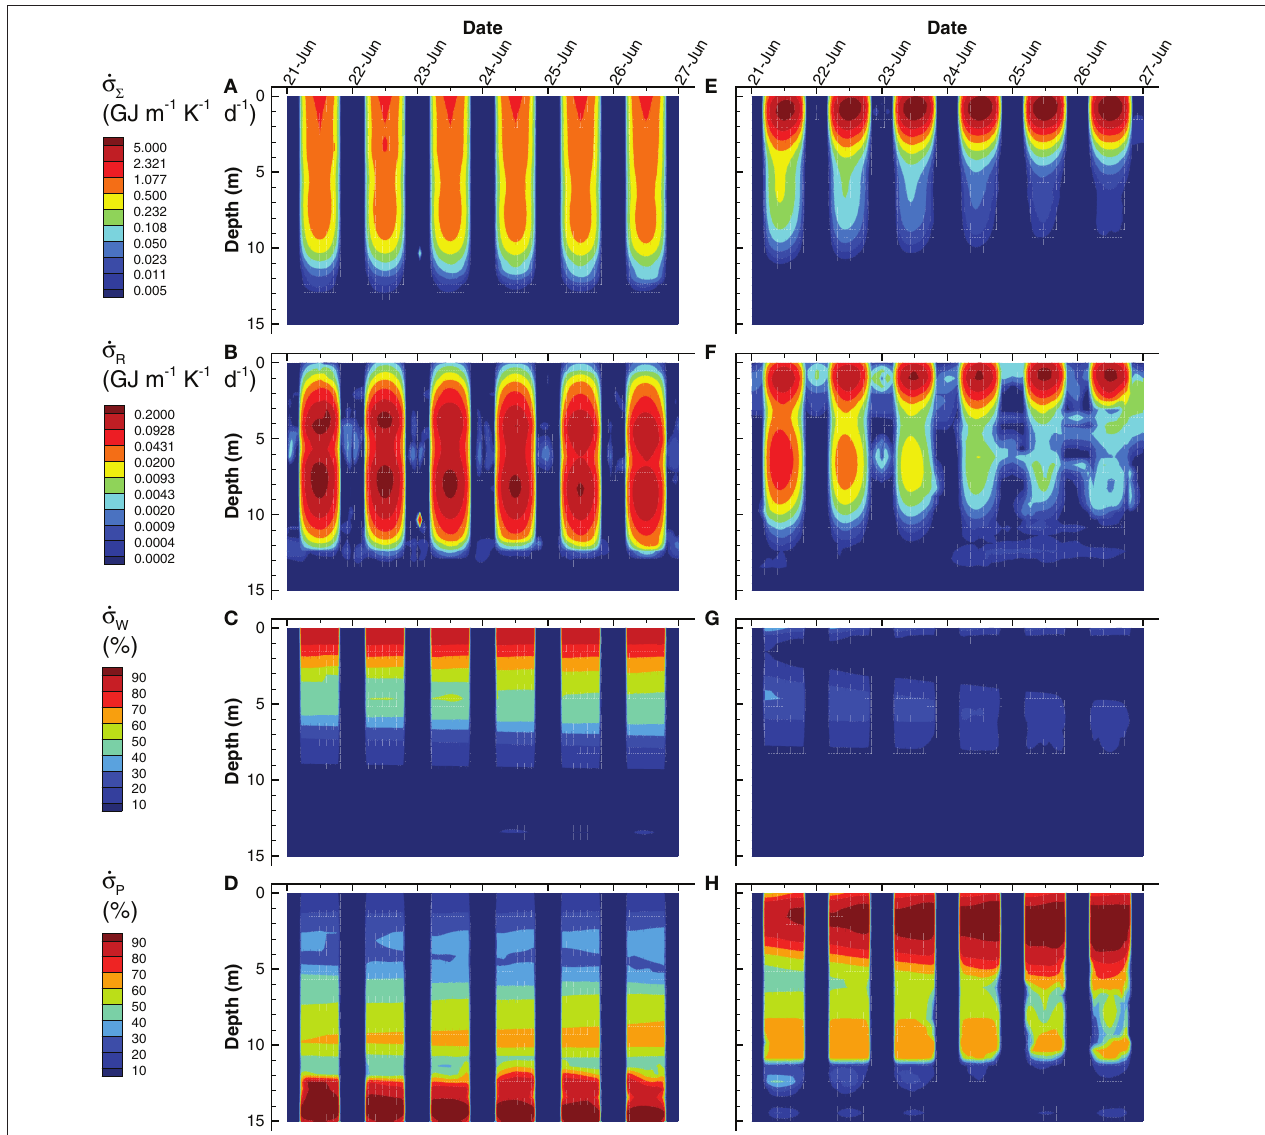
FIGURE 7 | Contour plots of simulated total entropy production, ˙ σ 6 (Eq. (S178)) (A,E) , entropy production from reactions, ˙ σ R [Equation (S178)] (B,F) , and entropy production from light absorption by water, ˙ σ W ( t , z ) [Equation (S176)] (C,G) and particles, ˙ σ P [Equation (S177)] (D,H) for the SIO (left column) and LIO (right column) simulations. Entropy production from light dissipation by water and particles are shown as a percentage of total entropy production.